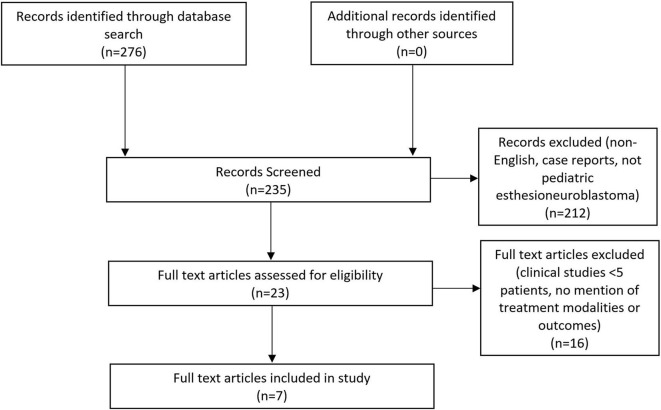
Preferred Reporting Items for Systematic Reviews and Meta-Analyses (PRISMA) flow diagram highlighting the literature selection process.